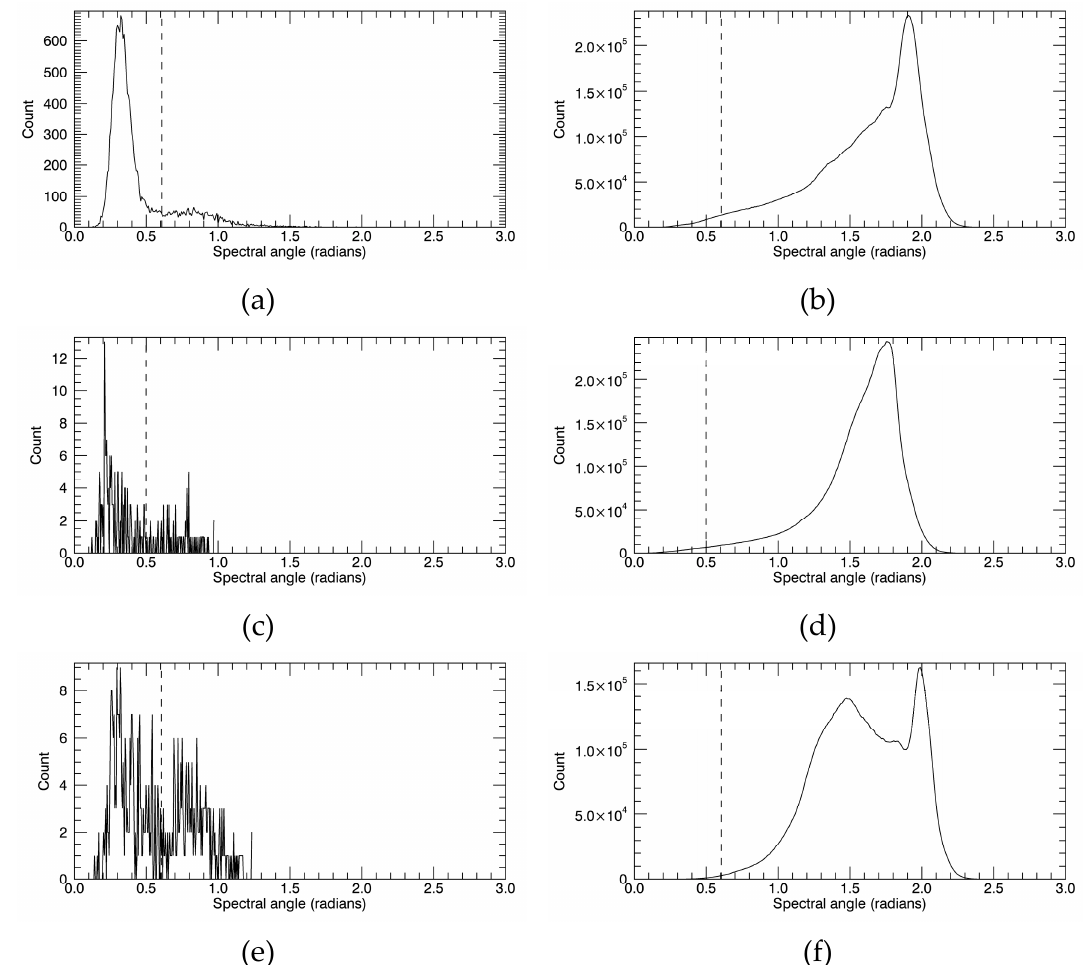
Figure 13. The histogram (solid line) of a rule image that contains the classification measures in units of radian for each training area: ( a ) Avicennia marina , ( c ) Rhizophora stylosa and ( e ) Lumnitzera racemosa ; and for the entire strip: ( b ) Avicennia marina , ( d ) Rhizophora stylosa and ( f ) Lumnitzera racemosa . The threshold (dashed line) for each mangrove species is determined by Otsu’s method to dichotomize the image into the mangrove and the non-mangrove pixels in each training area. The same threshold is applied to the entire strip to map the same mangrove species. Table 3. The total area of mangroves calculated from the map derived from the CASI hyperspectral Table 2. The threshold value of each endmember determined by the histogram of a rule image. image (Figure 14) and the map derived from the field investigation by Wang et al. [27] (Figure 6). Source Map derived from the field investigation by Wang et al.